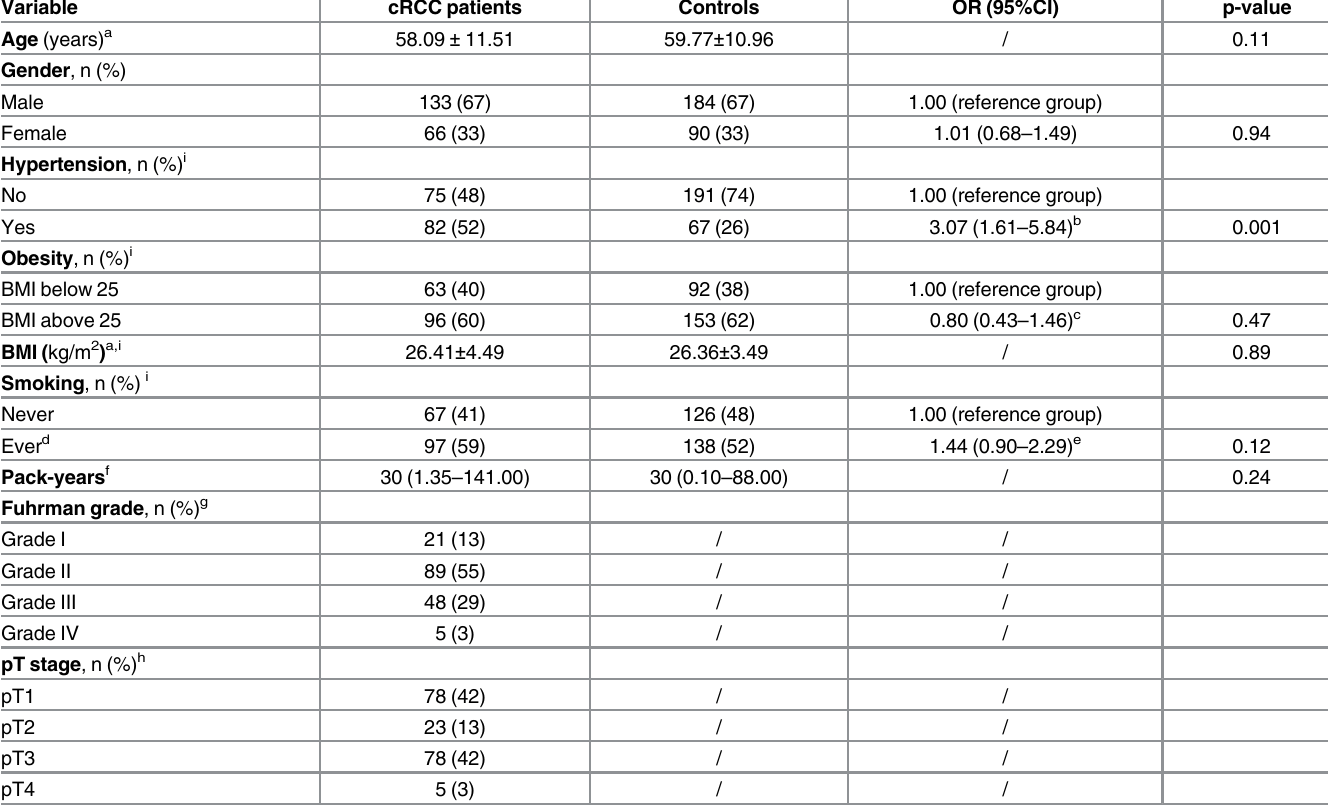
Table 2. Baseline characteristic of patients with cRCC and respective controls.